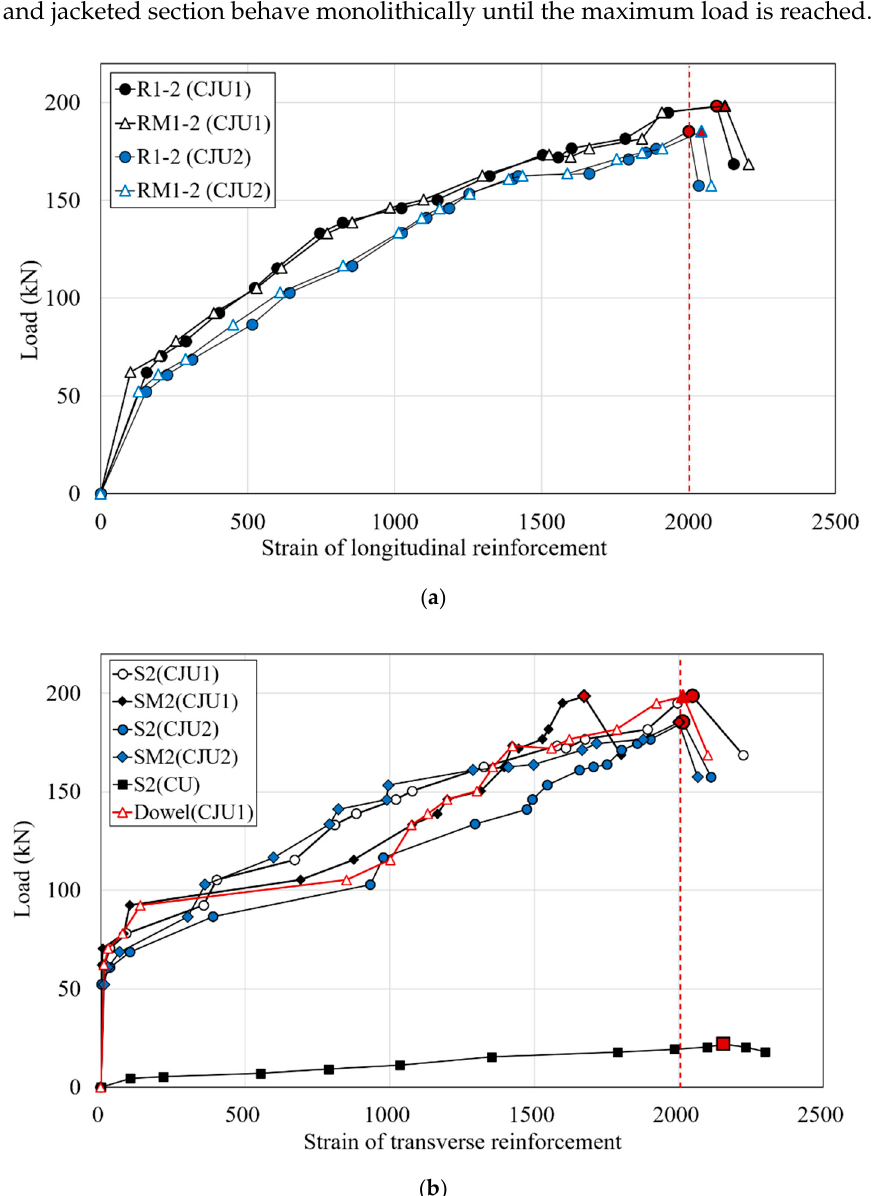
Figure 9. Strains of reinforcements: ( a ) longitudinal reinforcements; ( b ) transverse reinforcements.